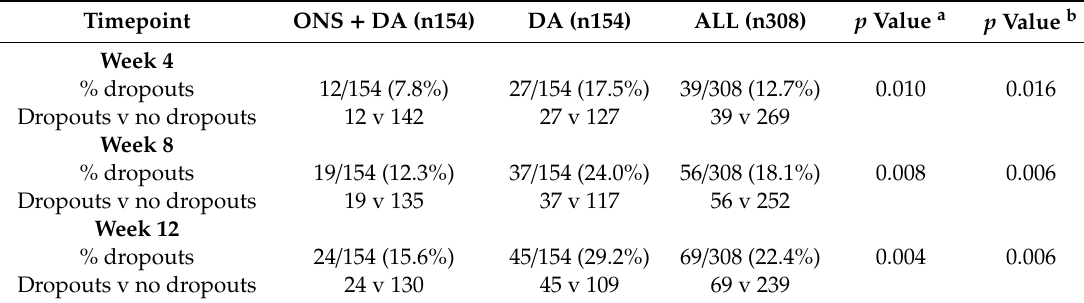
Table 2. Analysis of